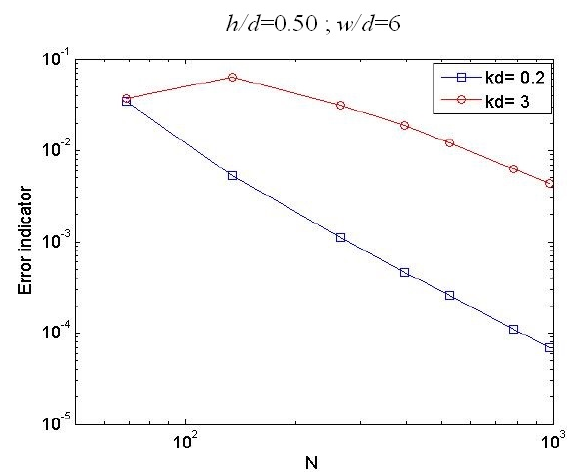
Figure 5. Error indicator versus the number of boundary nodes for different relative lengths.